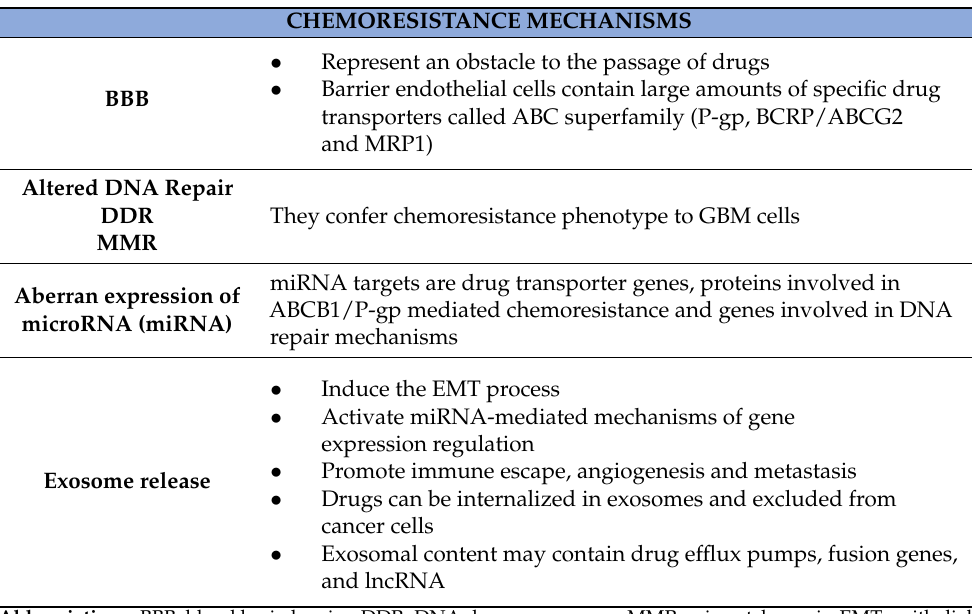
Table 2. GBM chemoresistance principal